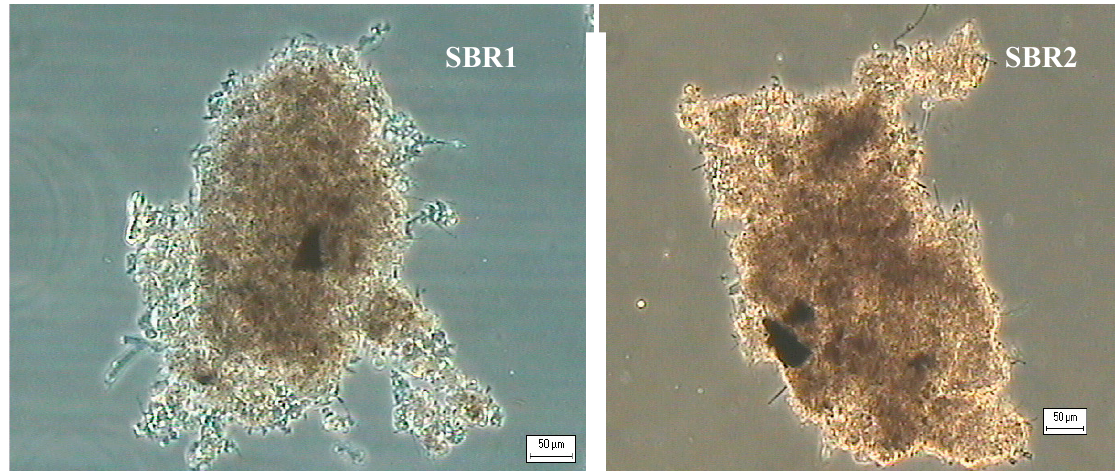
Figure 3. Floc structure during the second experimental period in the two reactors (100×).